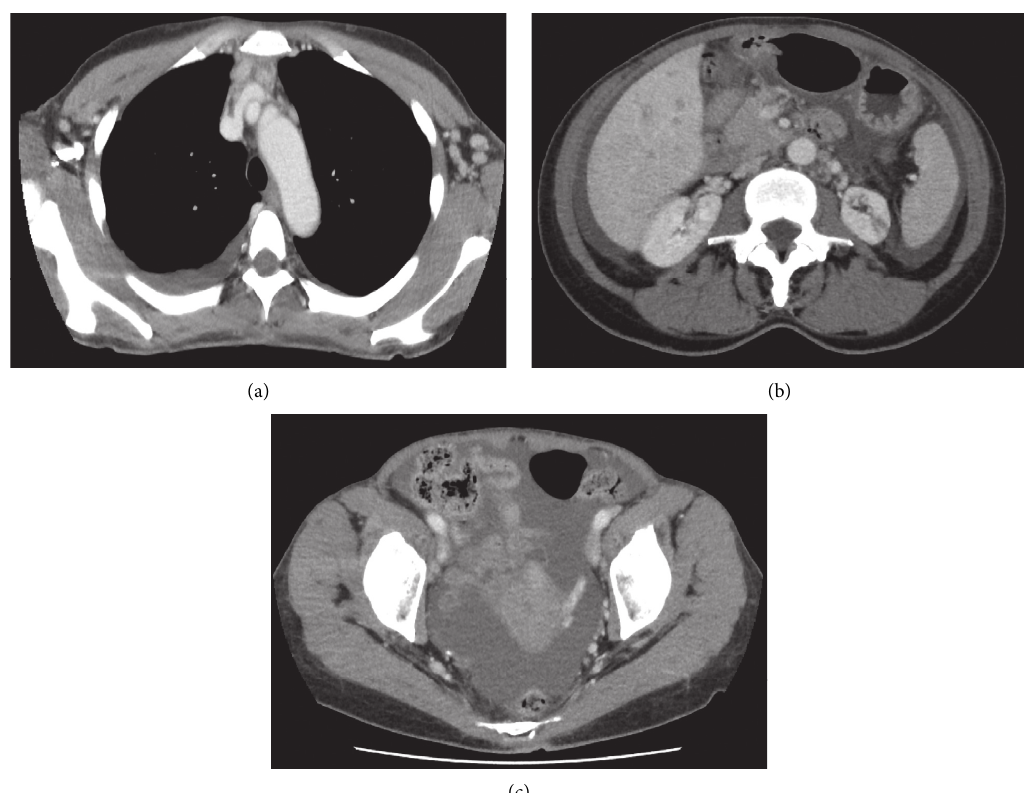
Figure 2: Computed tomography revealing enlargement of the axillary lymph nodes and right pleural effusion (a) and ascites around the liver and spleen (b) and in the pelvic cavity (c).